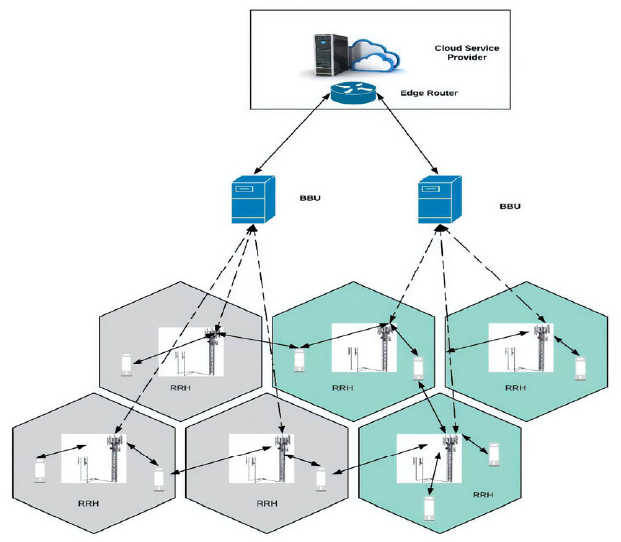
Figure 2. Modified C-RAN Architecture.